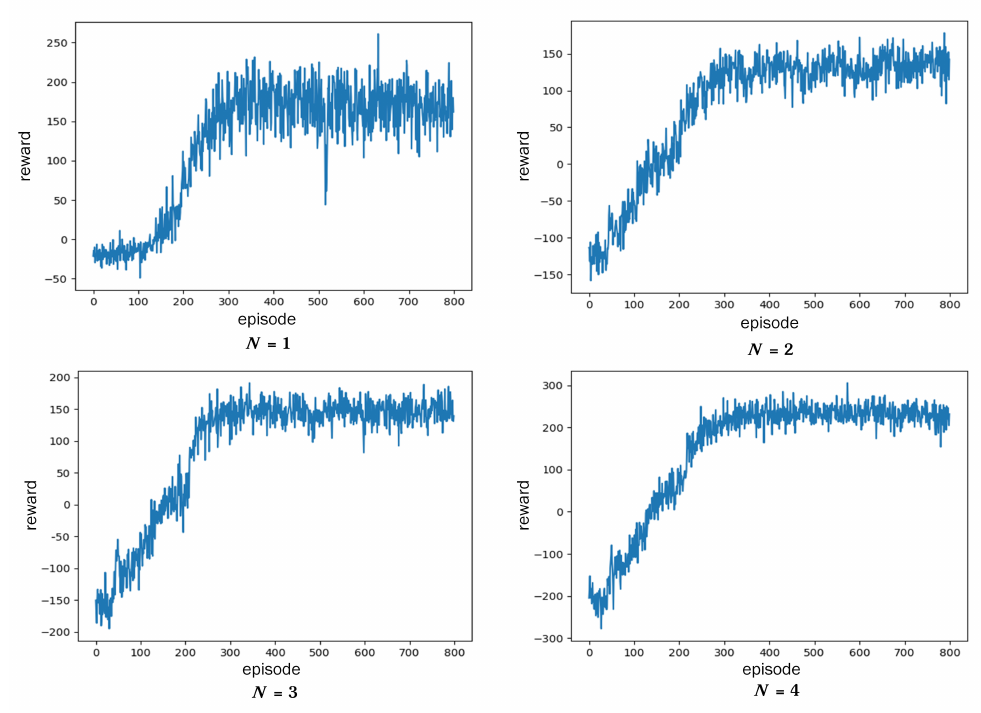
Figure 5. Convergence of the DDPG